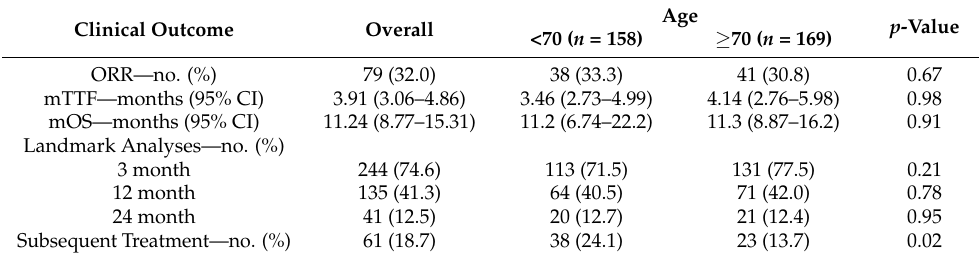
Table 2. Summary data of the relevant clinical outcomes based on age (cut-off 70 years-old). Clinical